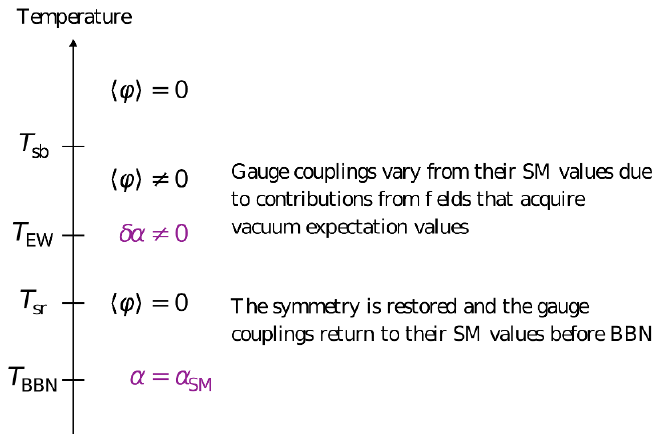
Figure 9 . An example of the cosmological history that is expected in the symmetry-breaking